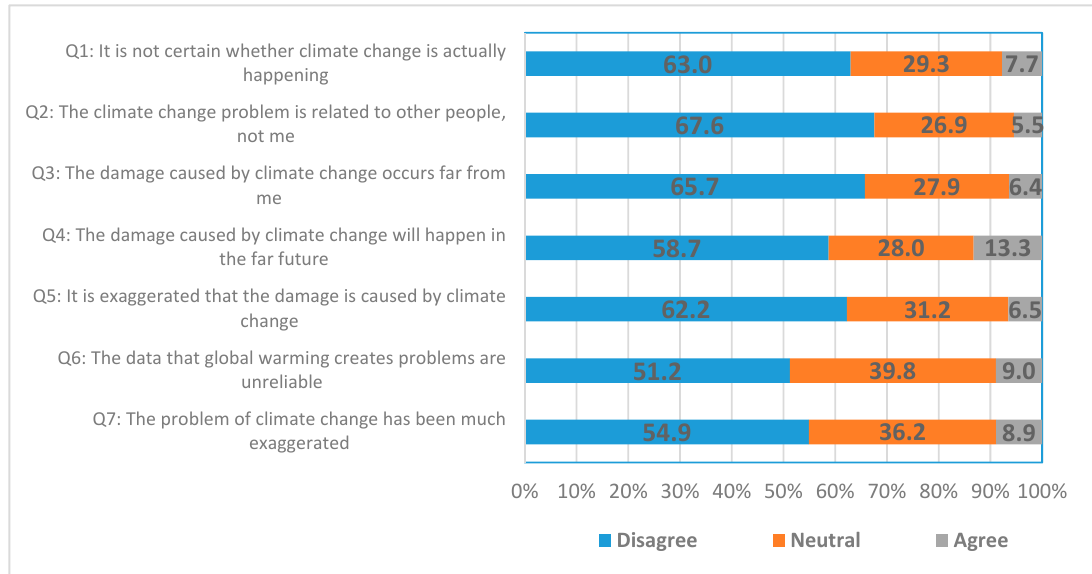
Figure 2. Attitudes toward climate change.